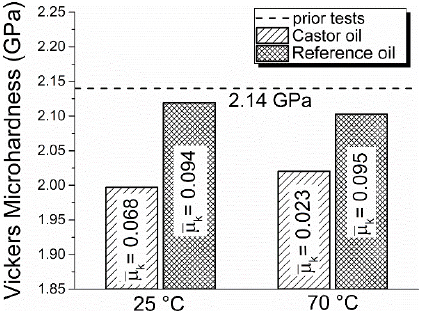
Figure 8. Evaluation of Vickers Microhardness on wear track surface of AISI 4140 tested against WC lubricated with Castor and Reference oil at 25 and 70 °C.